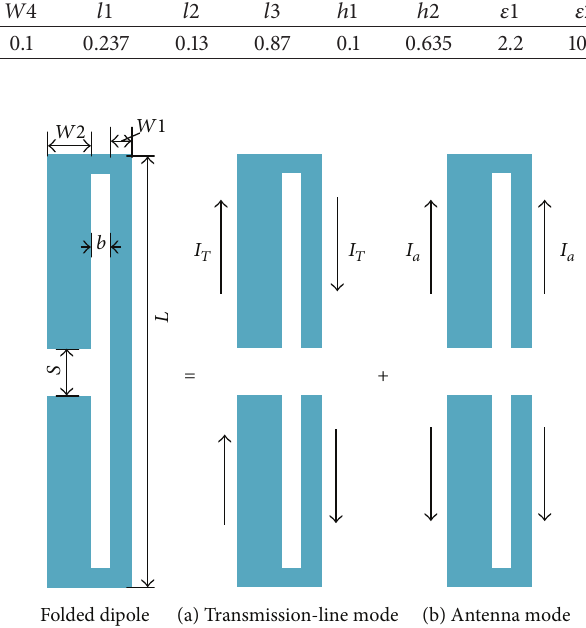
Figure 3: Current distribution on a folded dipole.